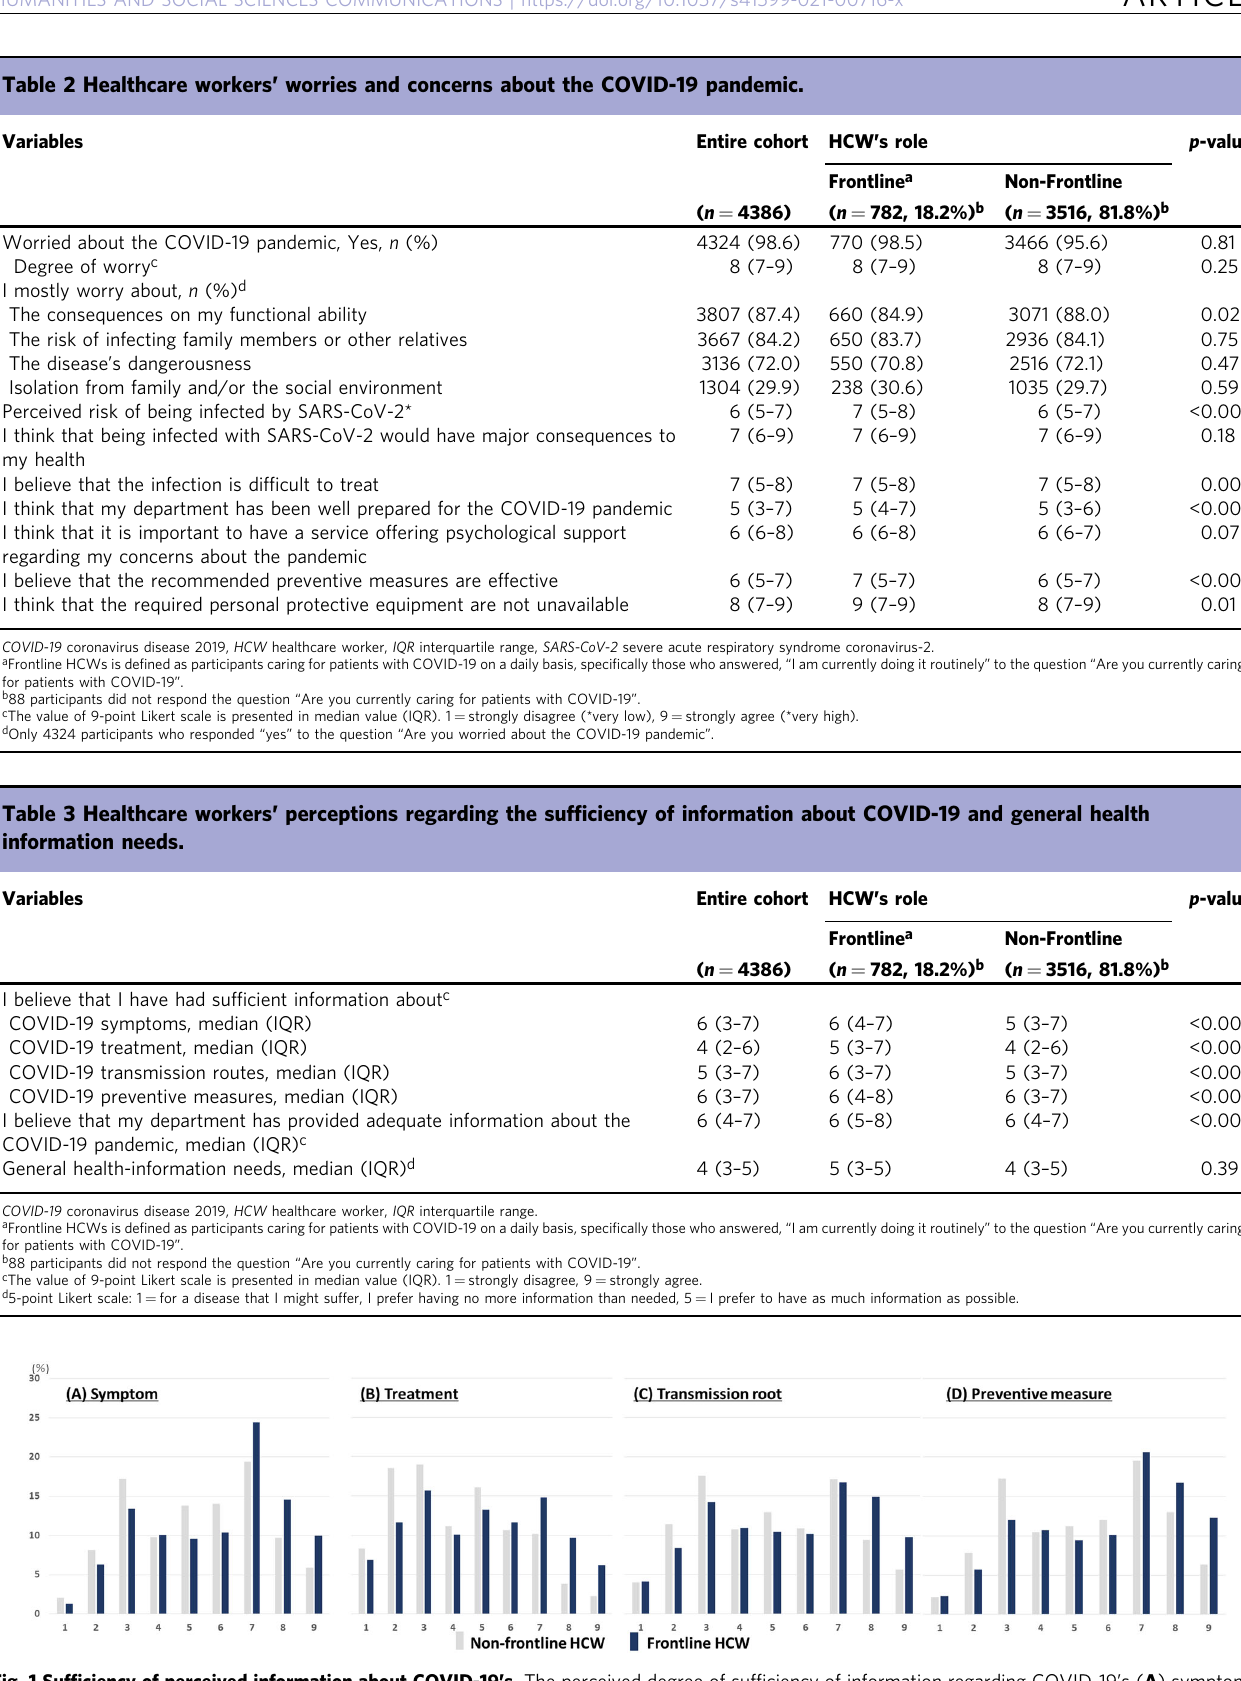
Fig. 1 Suf fi ciency of perceived information about COVID-19 ’ s. The perceived degree of suf fi ciency of information regarding COVID-19 ’ s ( A ) symptoms, ( B ) treatment, ( C ) route of transmission, and ( D ) preventive measures. The x axis represents the response on a 9-point Likert scale, with 1 point indicating that the respondent felt strongly that information was lacking and 9 points indicating that they felt strongly that the information was suf fi cient. For all four issues, frontline HCWs are more satis fi ed with the amount of information than were non-frontline